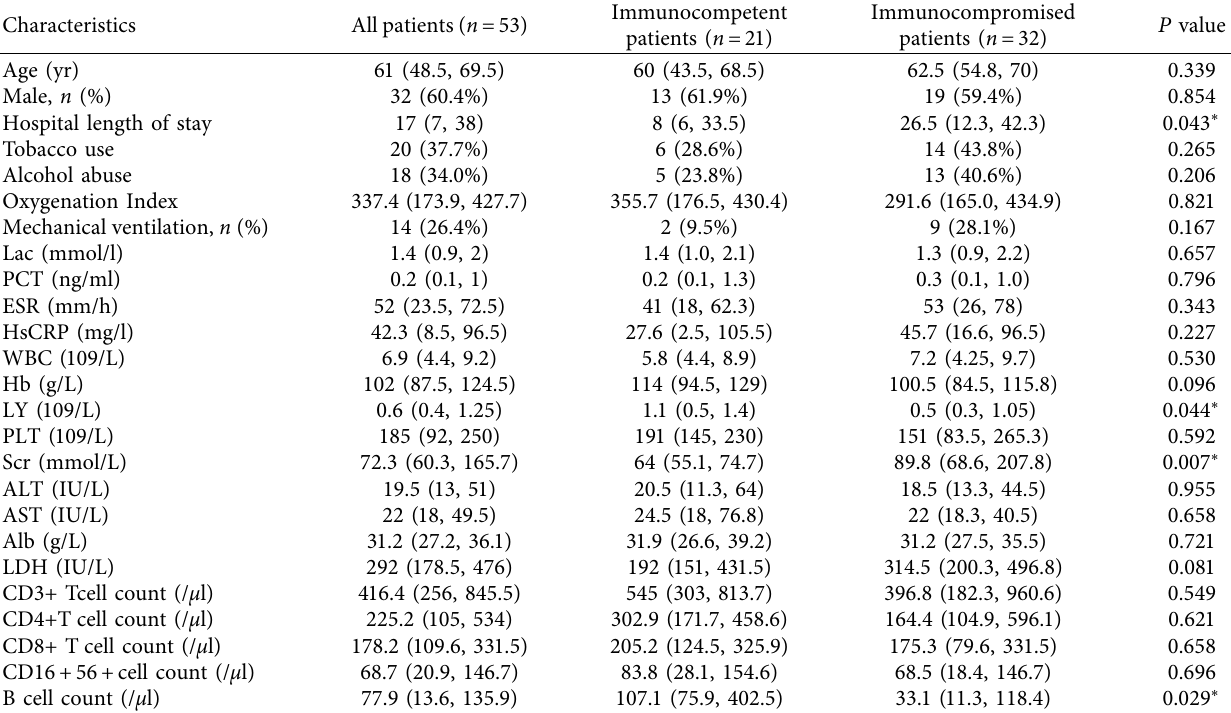
Table 1: Patient characteristics and baseline of two